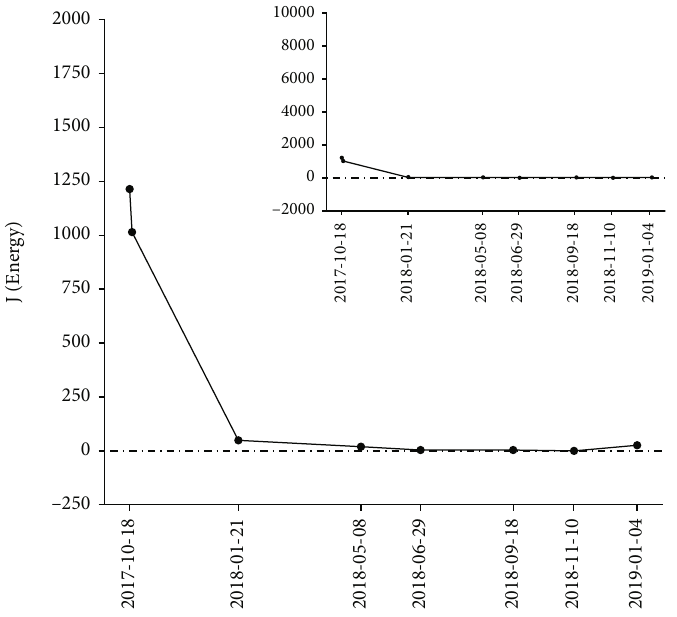
Figure 10: The kinetic energy of ZK4-1